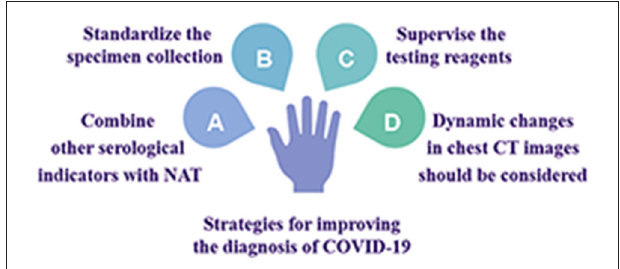
FIGURE 2 | Strategies for improving the diagnosis of